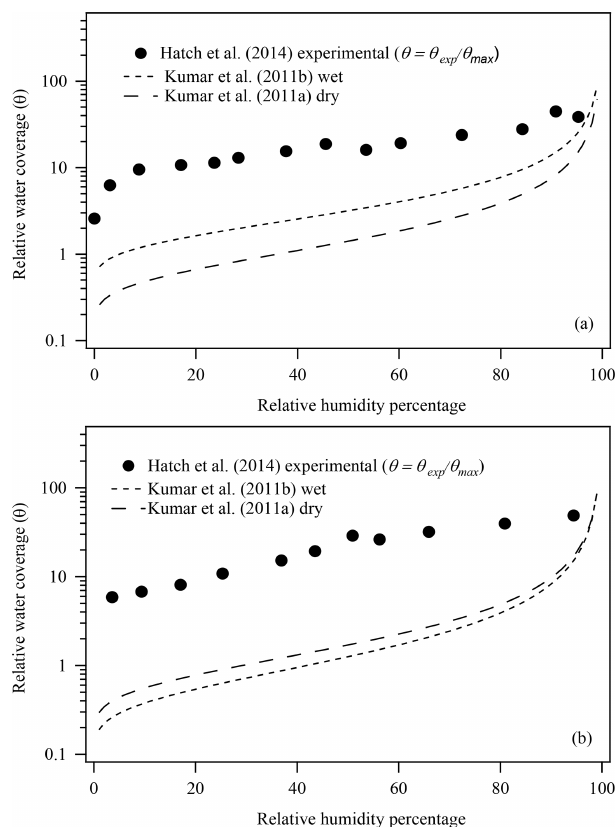
Figure 1. Comparison of previously reported experimental wa- ter adsorption isotherms ( θ = θ exp /θ max ) and FHH adsorption isotherms from FHH parameters determined from size-selected CCN measurements of (a) illite and (b) montmorillonite aerosol generated using wet or dry aerosol generation methods (Hatch et al., 2014; Kumar et al., 2011a,